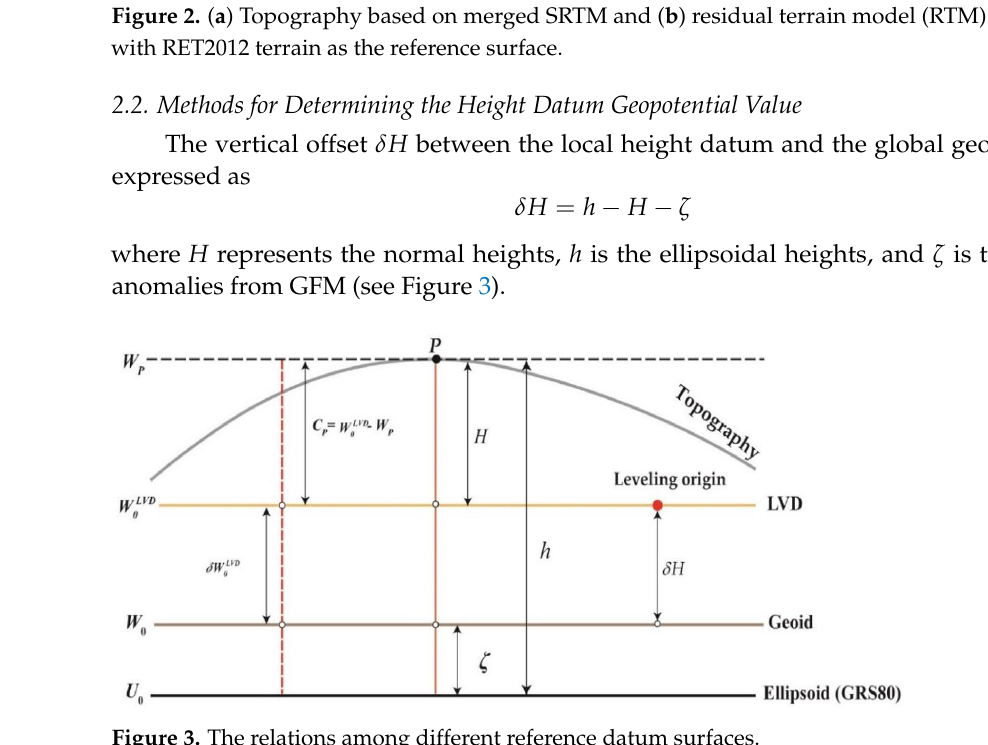
Figure 3. The relations among different reference datum surfaces.